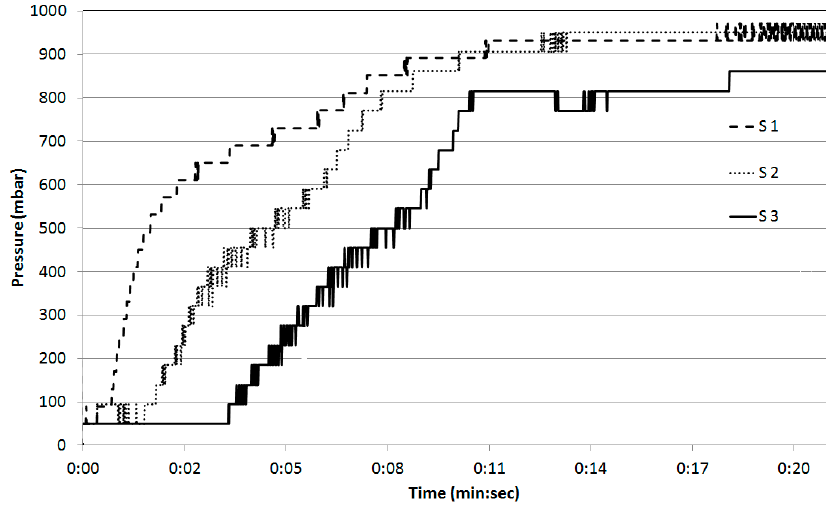
Figure 2. Measured pressure during resin infusion by pressure sensors. The laminate is filled up with the resin in 21 min.